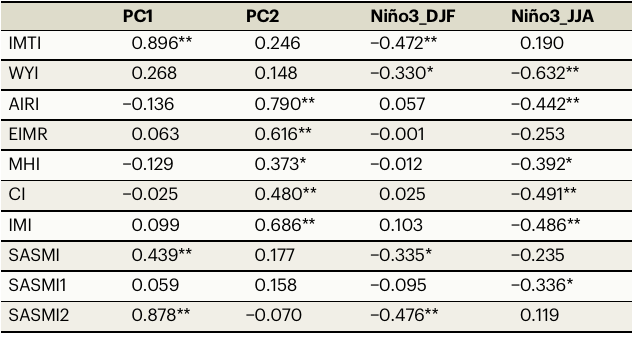
Table 2 | Correlation coef fi cients between the South Asian summer monsoon indices and principal components (PCs), and the preceding winter and simultaneous summer Niño-3